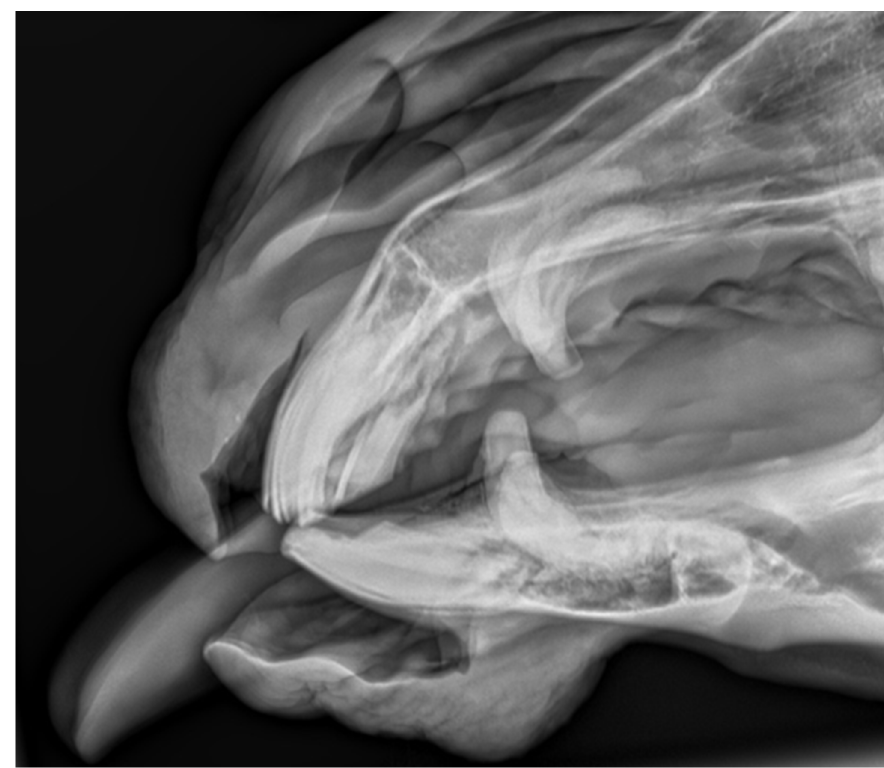
Figure 5. Case 1—lateral projection of the incisal area.